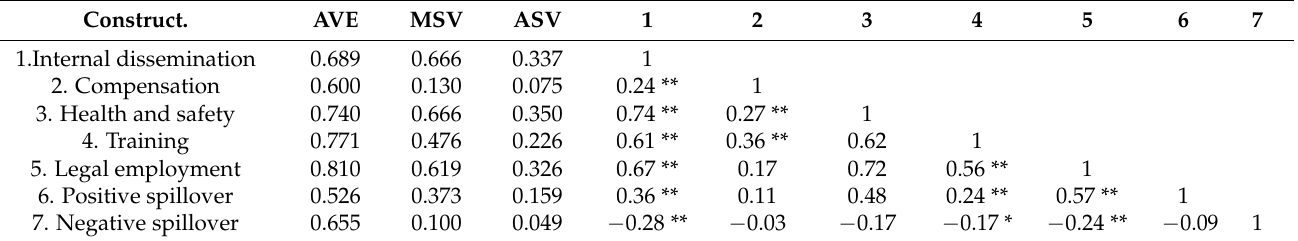
Table 1. Correlation and validity among